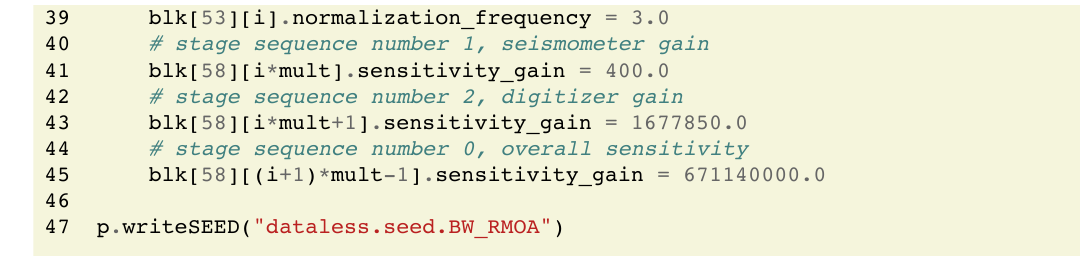
Figure 16 (continues from previous page). Example code: Cloning a Dataless SEED file, filling in all of the important